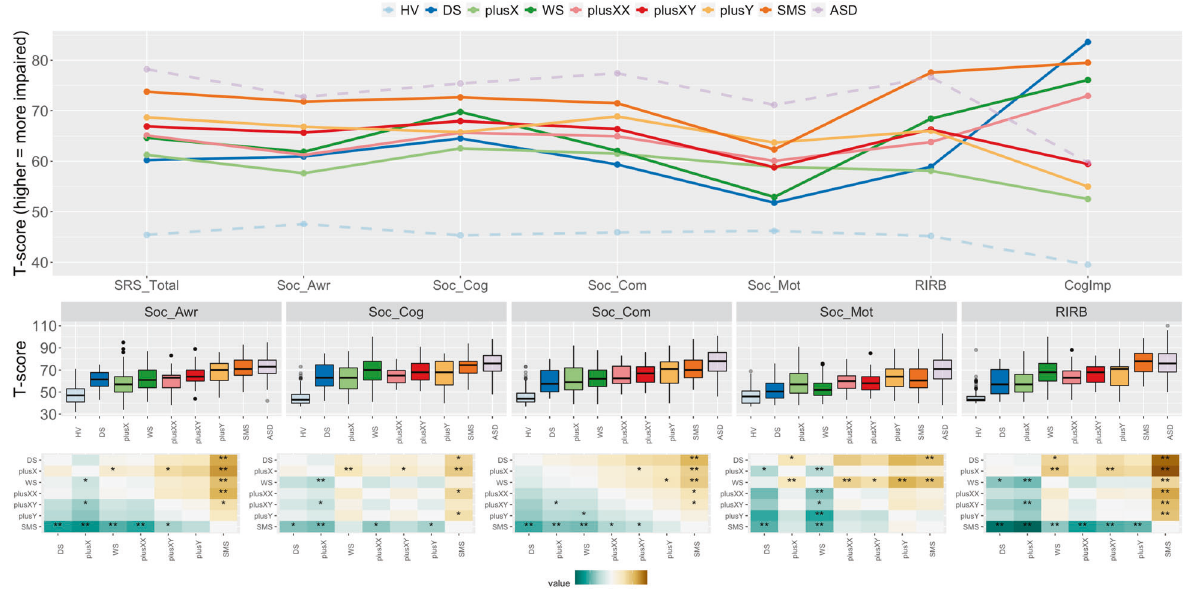
Fig. 2 Gene dosage disorder (GDD) scores for different autism-related traits (ARTs). Top panel: Point-line graph showing score pro fi les for each GDD across ARTs. Color encodes group. GDDs are in solid lines, and the benchmark autism spectrum disorder (ASD) and healthy volunteer (HV) groups are in dashed lines. Middle panel : Boxplots for each ART showing GDD group score distributions. Bottom panel : Heatmaps for each ART showing Cohen ’ s d effect sizes for all pairwise GDD group comparisons (column group vs. row group). Asterisks denote statistically signi fi cant comparisons (*nominal p < 0.05, **surviving Bonferroni correction for multiple comparisons).